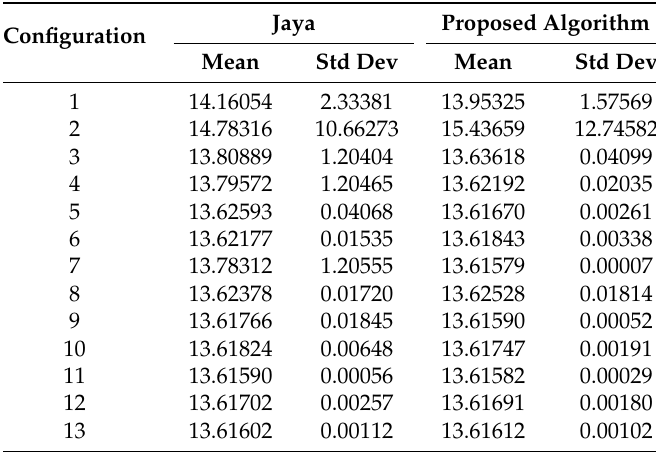
Table 14. Comparison of the solution quality between Jaya and the proposed method. Each row corresponds to 100 independent runs. Current step size = 1